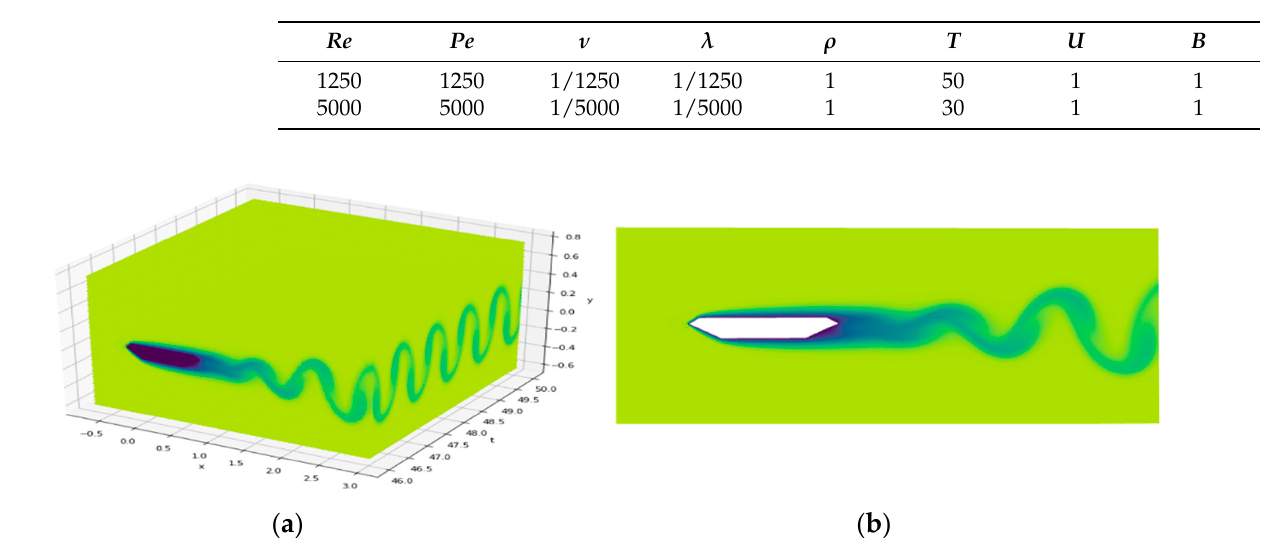
Figure 4. Training data for Re = 1250: ( a ) Concentration field for Re = 1250 at T = 46–50; ( b ) Concen- tration field for Re = 1250 at T = 46.